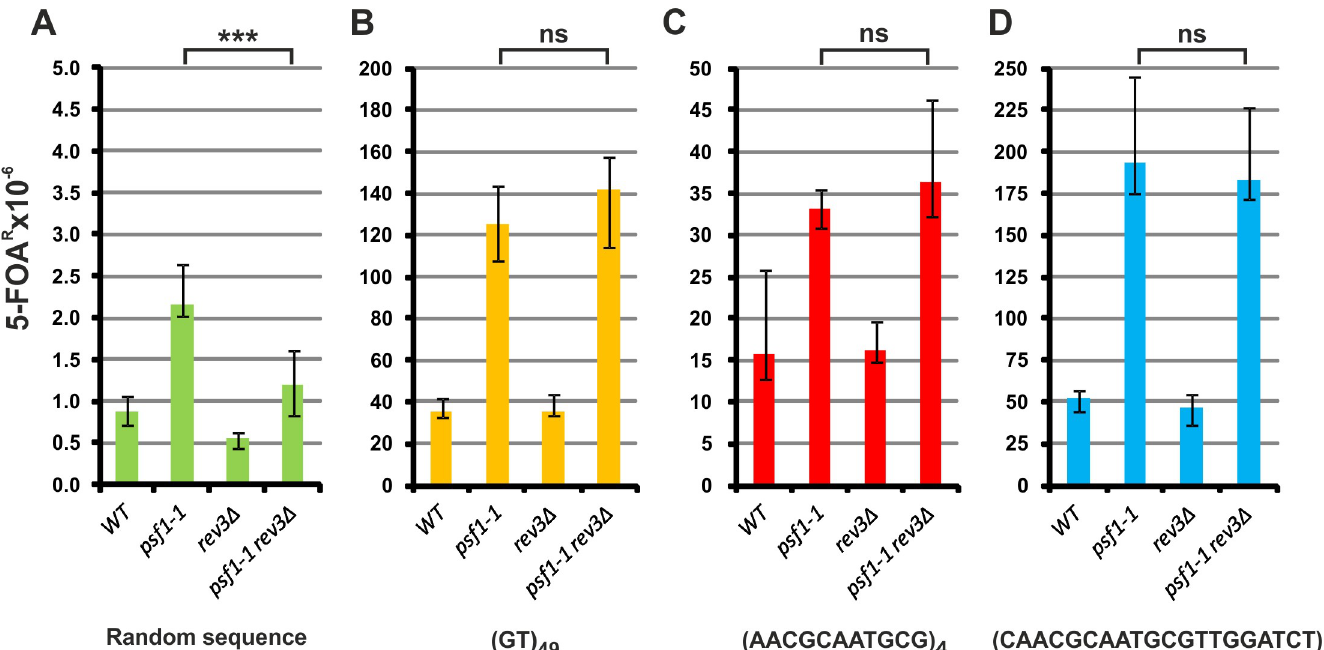
Fig 4. Pol z has no effect on repeat tract stability in psf1-1 (A-D). The 5-FOA R mutation rates were determined at 23˚C for yeast cells with the indicated genotypes carrying plasmids with the analyzed sequences; the values are medians with 95% confidence intervals calculated from data for at least ten cultures of each strain; the p values for psf1-1 rev3 Δ versus psf1-1 mutant strains were calculated using the nonparametric Mann-Whitney U statistical test ( ��� p � 0.001; ns– p > 0.5). All associated p - values are presented in the S1 Table.